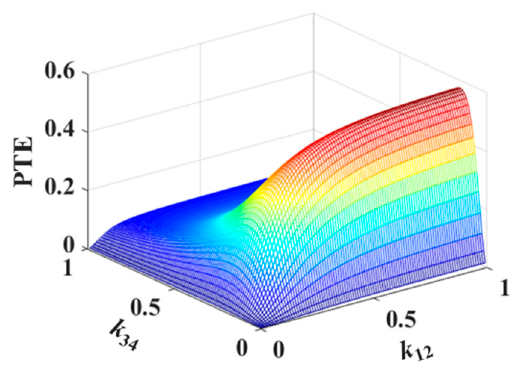
Figure 2. The relationship between power transfer efficiency (PTE) and k 12 and k 34.